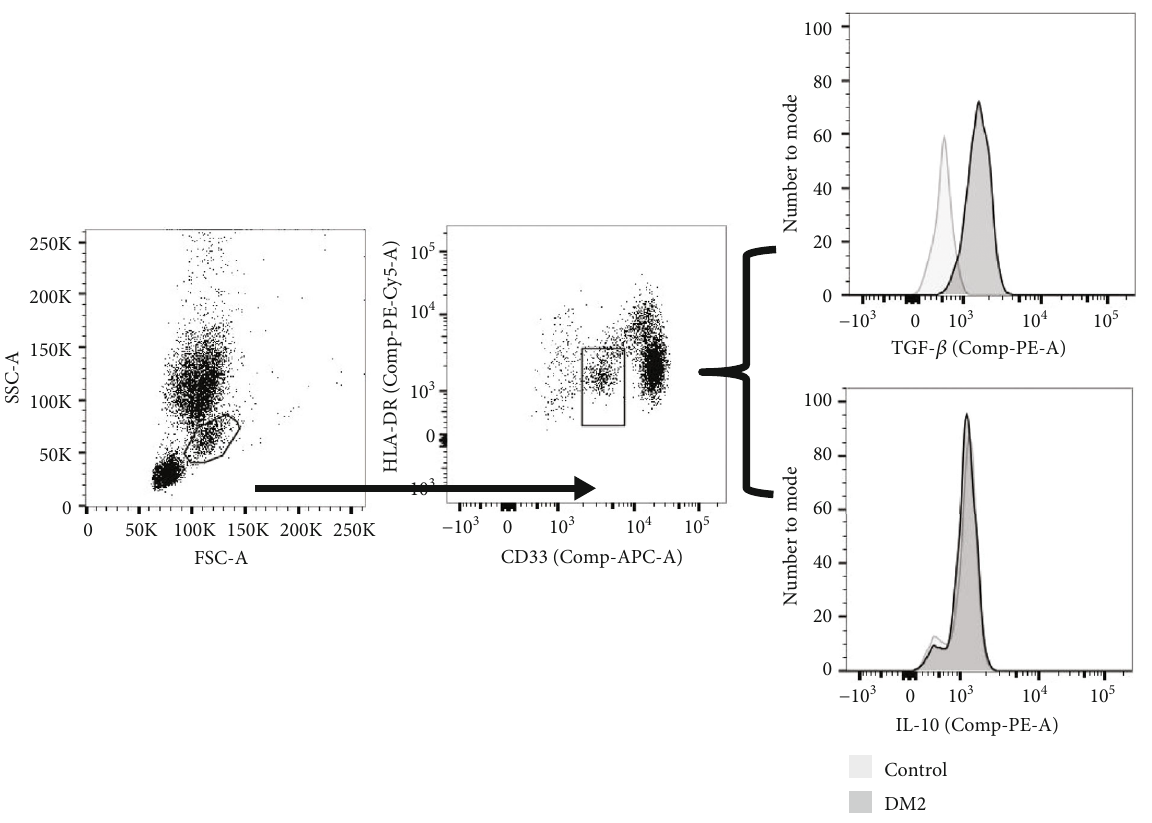
Figure 2: CD33+ HLA-DR-/low MDSCs produce IL10 and TGF- β . Representative data of the intracellular staining of IL-10 and TGF- β on CD33+ HLA-DR-/low MDSCs. Data were obtained in a BD FACSCanto II® Flow Cytometer and were analyzed with the software FlowJo® v10.0. Table 2: Comparison of serum cytokine concentrations among study groups #